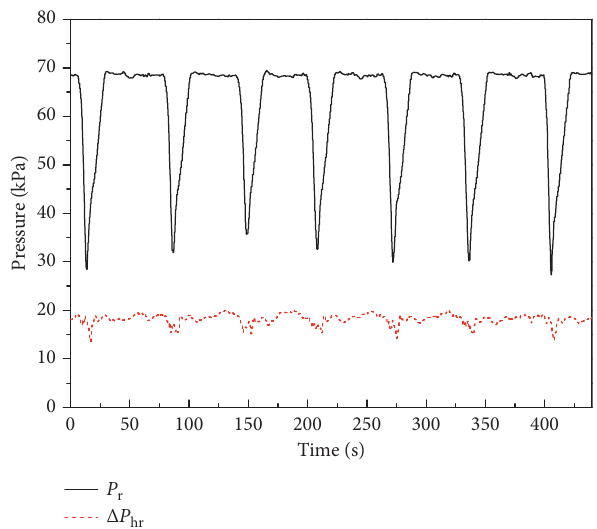
Figure 6: Pressure of P